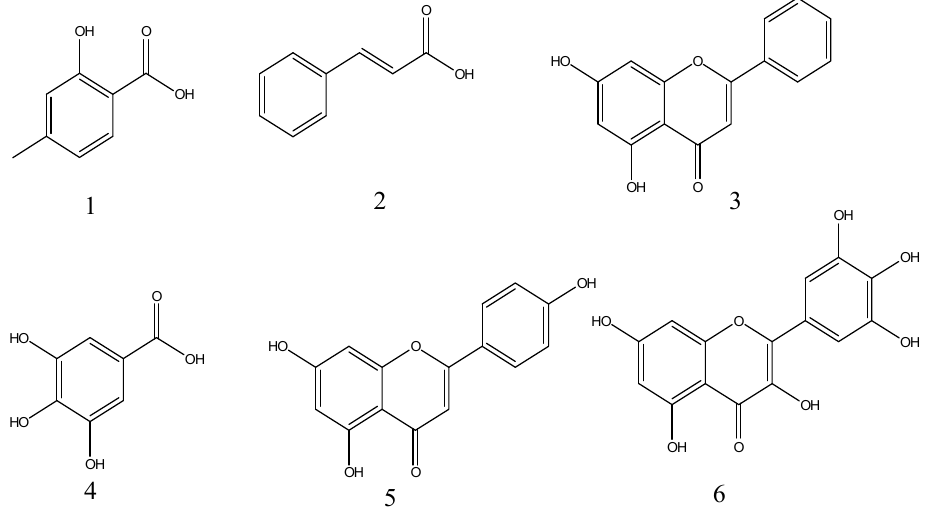
Figure 1. Structural composition of isolated compounds 4-methyl salicylic acid. ( 1 ) Cinnamic acid ( 2 ) Chrysin, ( 3 ) Gallic acid, ( 4 ) Apigenin, ( 5 ) Myricetin, and ( 6 ) from propolis methanol fraction.